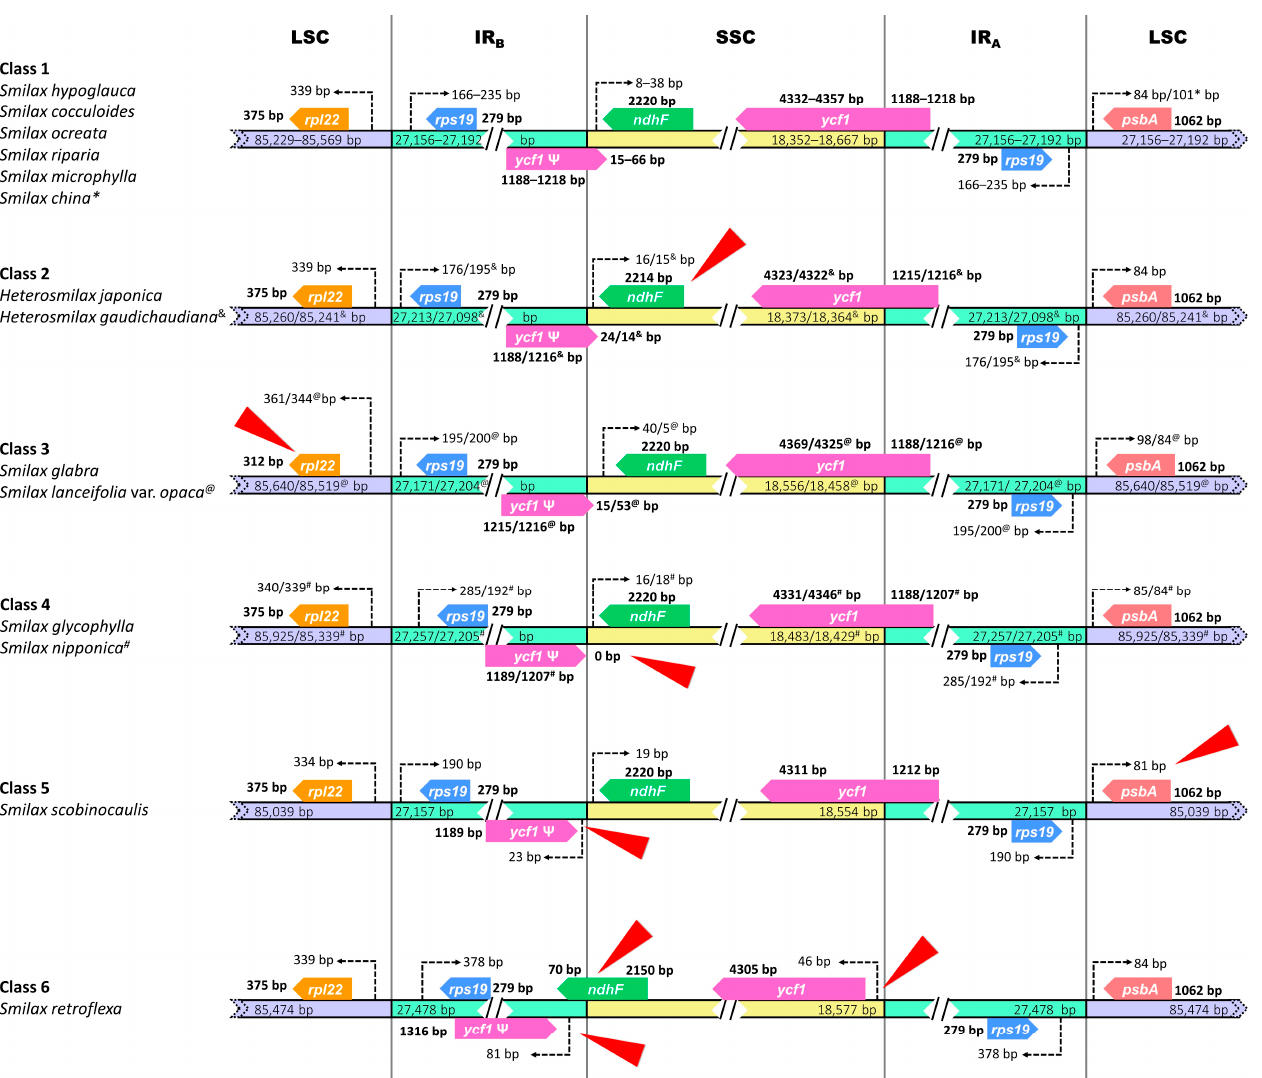
Figure 6. Boundary variations observed for the fourteen Smilacaceae species. The variations are highlighted with red triangles. The values marked with *, & , @ , and # belong to S. china , H. gaudichaudiana , S. lanceifolia var. opaca , and S. nipponica , respectively.